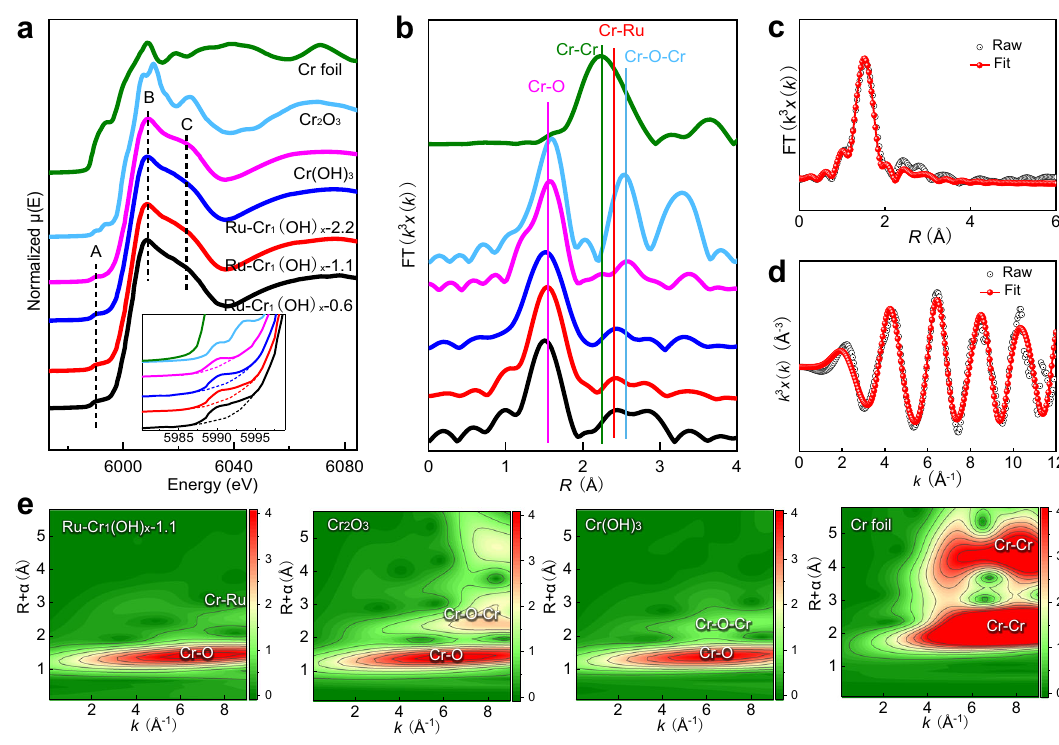
Fig. 3 | XAFS measurements of different samples at the Cr K-edge. a XANES spectra. The inset displays a magni fi ed view of the pre-edge peak A. b k 3 -weighted